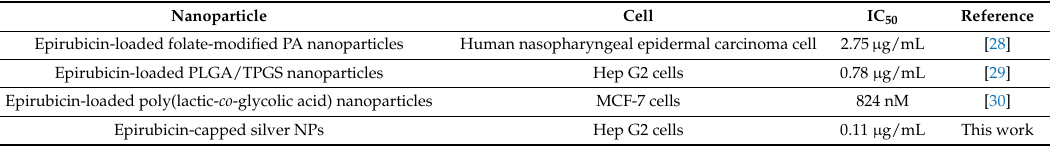
Table 2. Comparison of cytotoxic activities of reported epirubicin drug systems.